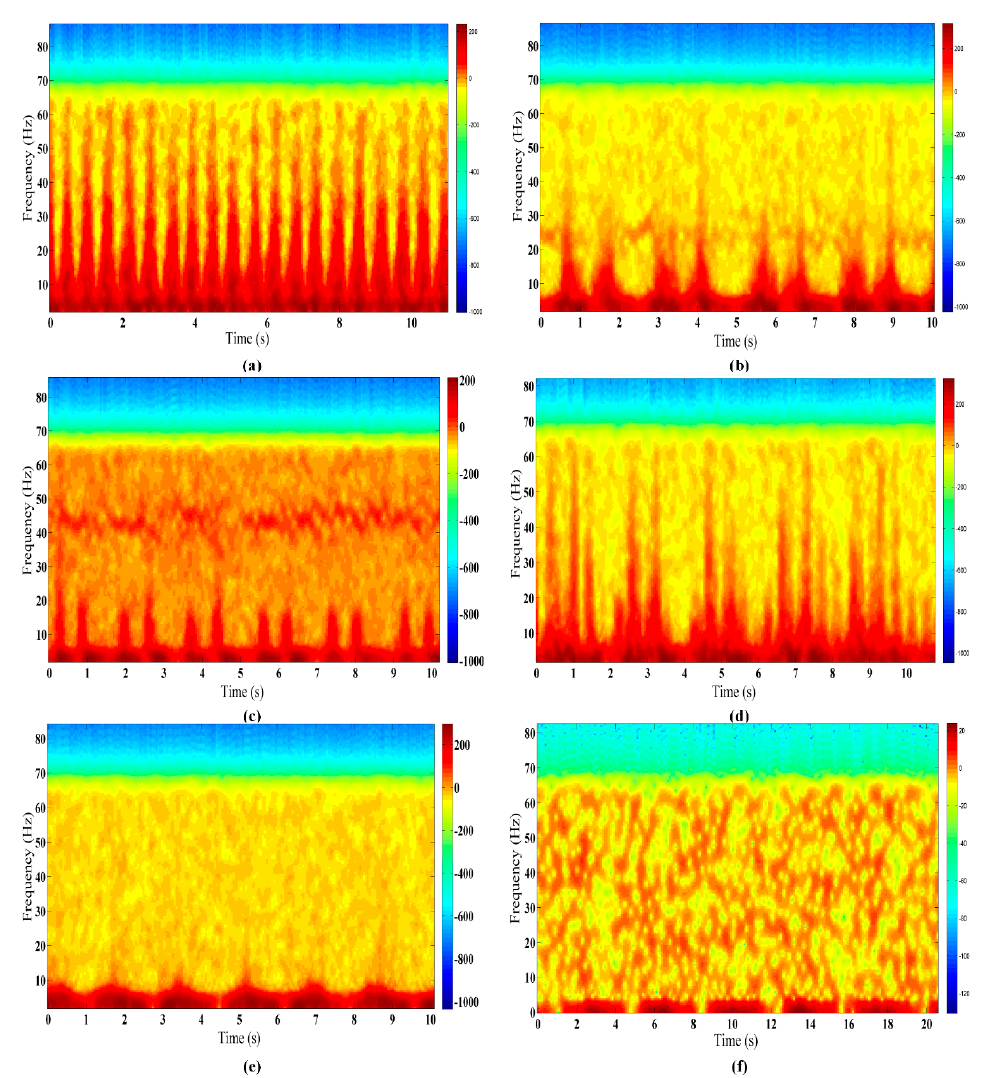
Figure 5. CRATFR spectrograms of six finer-grained human activities performed at 3 m behind a wall: ( a ) piaffe; ( b ) picking up an object; ( c ) waving; ( d ) jumping; ( e ) standing with random micro-shakes; and ( f ) breathing while sitting.